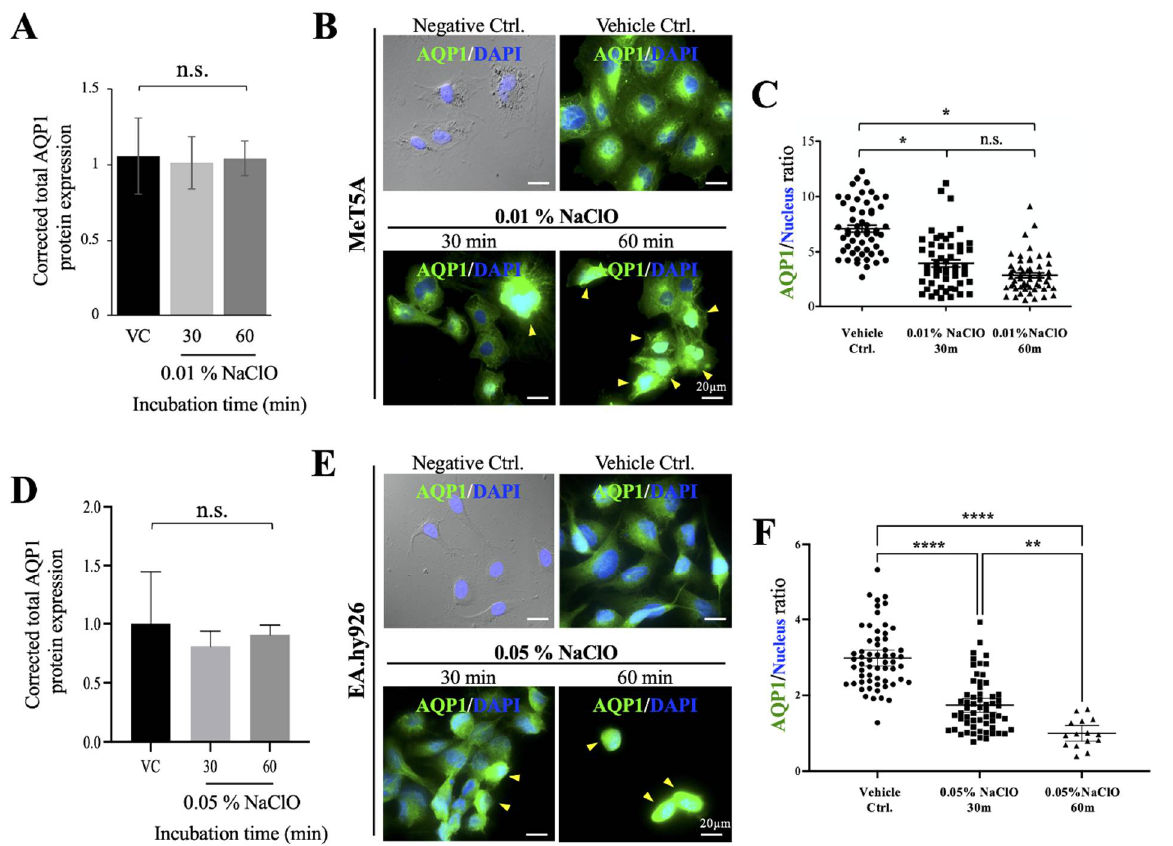
Figure 6. Cellular localization and protein expression of AQP1 in MeT5A and EA.hy926 under NaClO-induced oxidative damages. ( A ) Total AQP1 protein expression of MeT5A showed no differences after being treated with 0.01% NaClO within 60 min. ( B ) Immunofluorescence staining of AQP1 in MeT5A showed an aggregated signal (yellow arrowheads) around the nucleus region under 0.01% NaClO after 30 and 60 min when compared to a dispersed membrane pattern in control cells. ( C ) Self-defined cellular AQP1 distribution analyses showed significant differences in AQP1 distribution after MeT5A was treated with 0.01% NaClO after 30 and 60 min. ( D ) Total AQP1 protein expression of EA.hy926 showed no differences after being treated with 0.05% NaClO within 60 min. ( E ) Immunofluorescence staining of AQP1 in EA.hy926 showed aggregated signals (yellow arrowheads) around the nucleus region under 0.05% NaClO after 30 and 60 min when compared to control cells. ( F ) Quantification analyses showed the more dispersed cellular distribution of AQP1 in control EA.hy926 cells, and a concentrated (aggregated) AQP1 distribution after treatment with 0.05% NaClO. For each experimental condition, except for EA.hy926 at 60 min, 50 cells were evaluated, and representative images were presented. (* p < 0.05, ** p < 0.01, **** p < 0.0001, N.S. not statistical different).